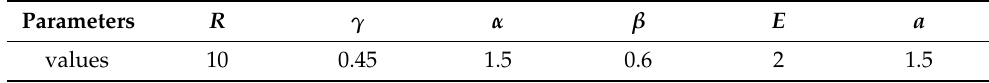
Table 3. Model parameter